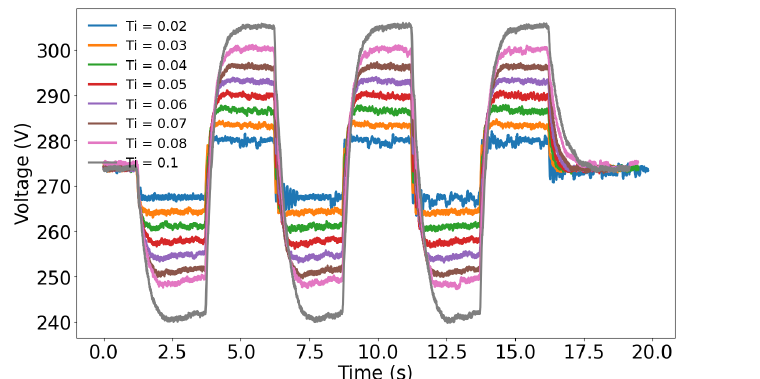
Figure 17. System voltage disturbance with a triangular feedforward signal, different T i and K p = 3.